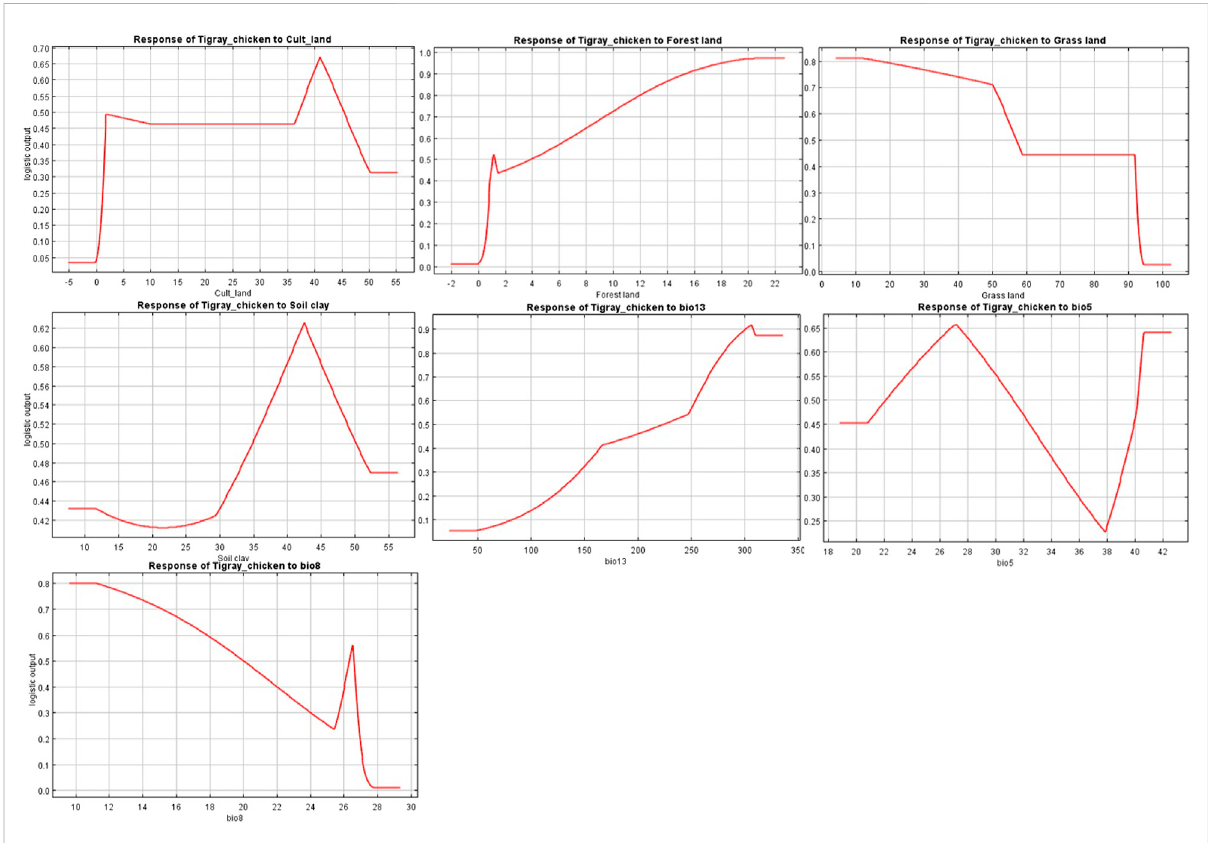
FIGURE 9 Individual response curves for seven environmental variables selected for the fi nal Maxent